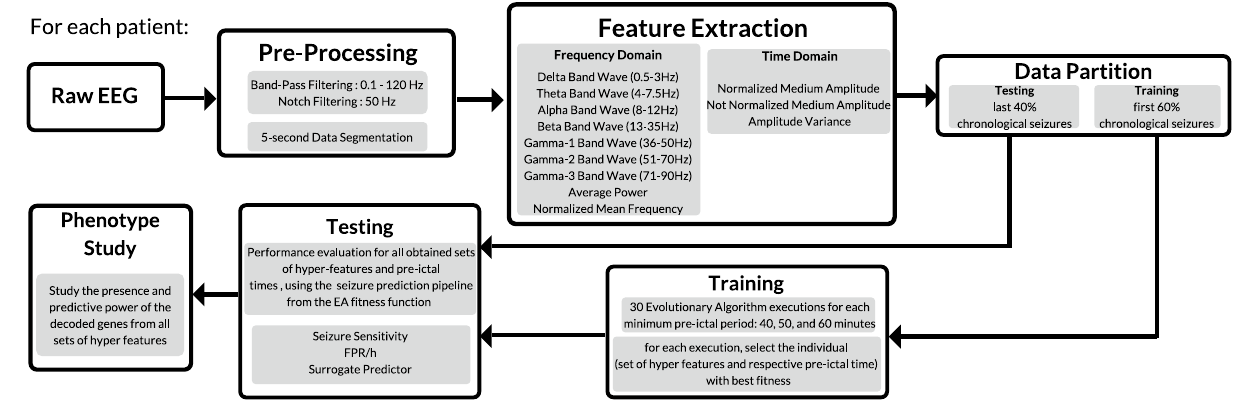
Figure 1. Flowchart of the proposed work for each patient, comprising data processing, feature extraction, training, testing, performance evaluation and phenotype study.